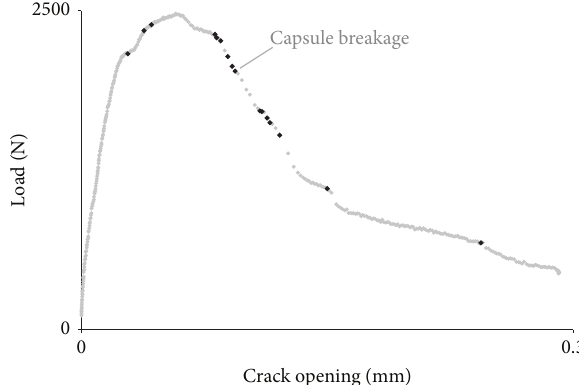
Figure 10: Capsules breakage events localization by AE at the load- crack opening